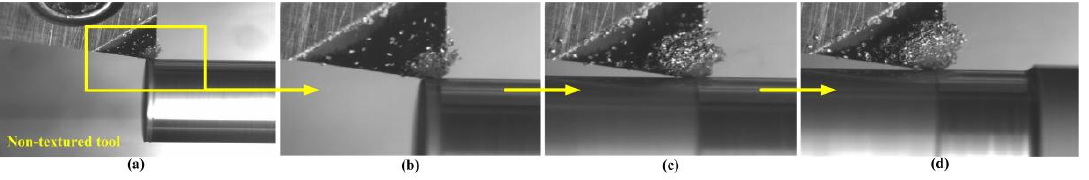
Figure 14. Snapshots of turning by non-textured tool. ( a – d ) show the chips in different turning time.